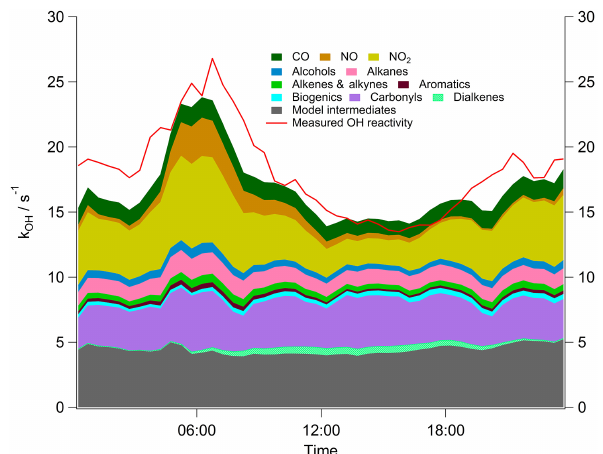
Figure 5. Average diurnal profile of measured reactivity and a breakdown of modelled reactivity into inorganic and organic classes when the model is constrained to the standard VOC suite measured by the dual-channel (DC)-GC-FID, the additional identified VOCs (including α -pinene and limonene; see Table 1 for details) measured by GC GC-FID and the unassigned GC GC-FID × ×